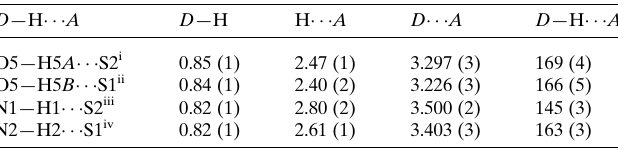
Table 1 Hydrogen-bond geometry (A˚ , (cid:4)